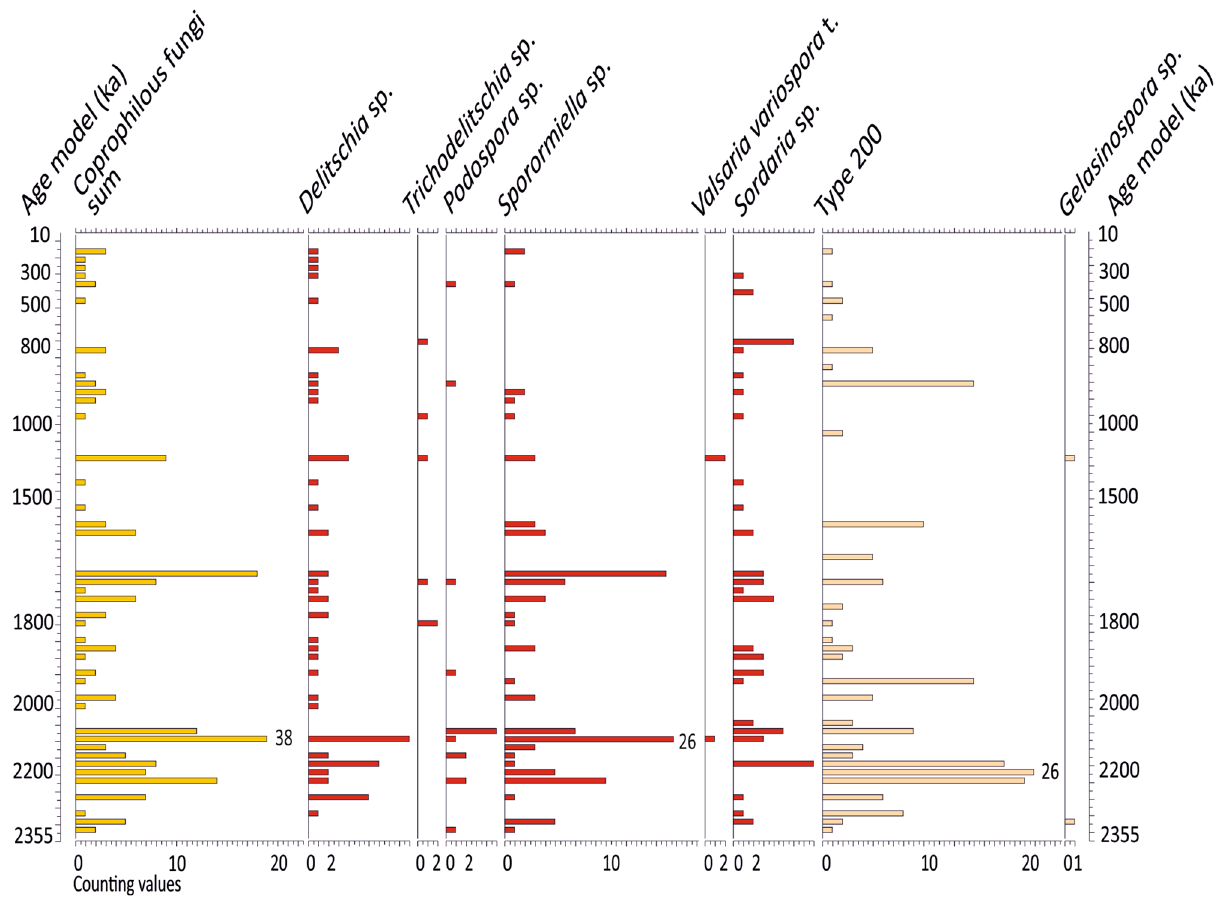
Figure 4. Coprophilous fungi spores of Acıgöl, core 3. Equidistant scale. Age model is from Demory et al. [1]. In red: coprophilous fungi